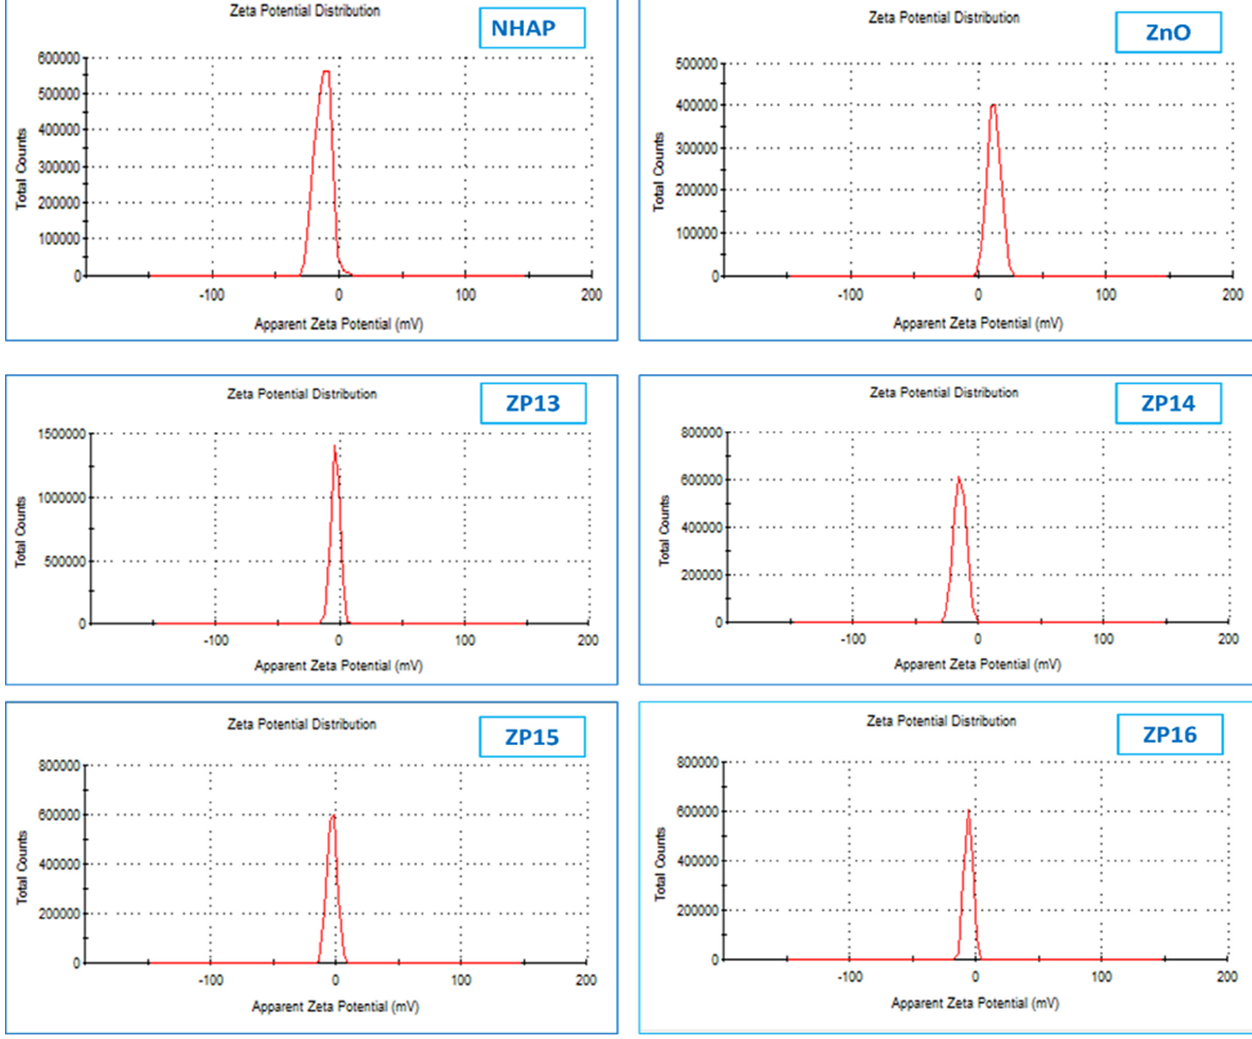
Figure 2. Zeta-potential analysis of synthesized NHAP, ZnO, ZP13, ZP14, ZP15, and ZP16. X-ray diffraction patterns for ZnO, ZP13, ZP14, ZP15, and ZP16 are displayed in Figure 3a. The nano zinc oxide sample shows sharp peaks located at 2 θ values of 31.7, 34.4, 36.2, 47.5, 56.6, and 62.8°, corresponding to the lattice planes of (100), (002), (101), (102), (110), and (103), respectively, based on JCPDS card no. 01-073-8417. The observed